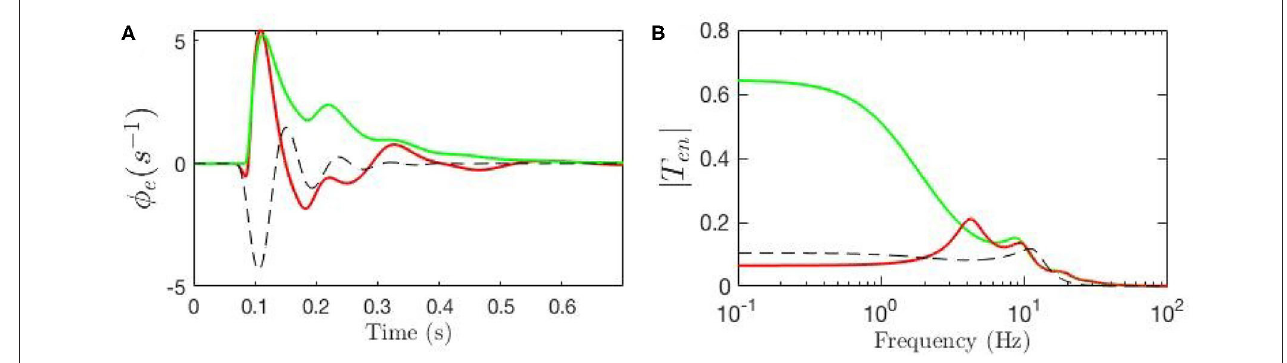
FIGURE 10 | Evoked potentials for the static-gain EEG parameters (green curve) and modulated-gain parameters starting from the same initial values (red). The dashed black line shows the contribution of the gain modulation, which adds to the green curve to give the red one. (A) Model cortical ERPs (B) Magnitude of the transfer